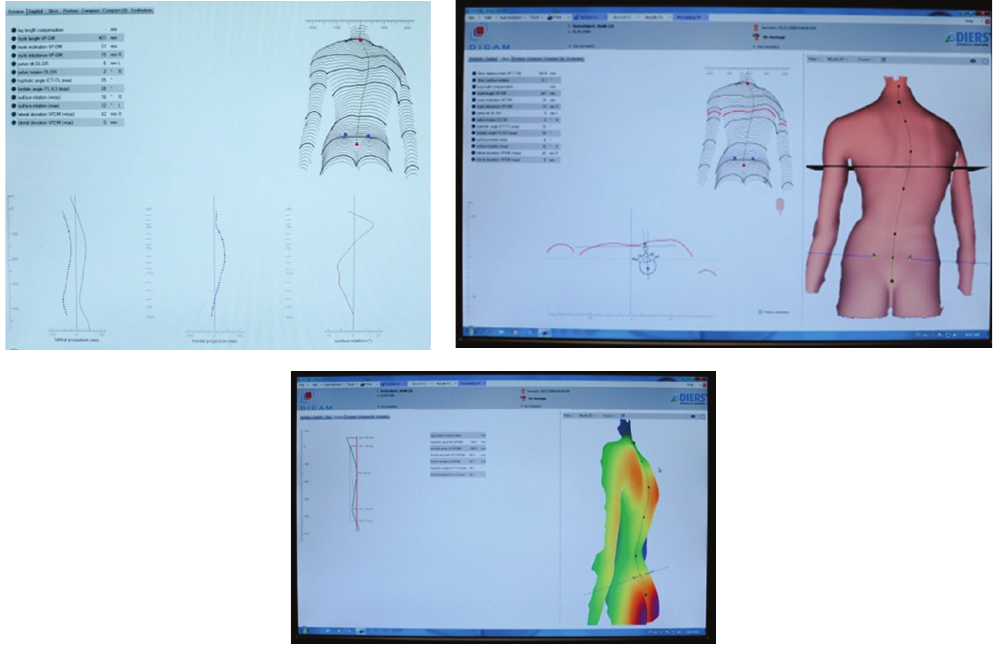
Figure 6: Diers Formetric sample data collection